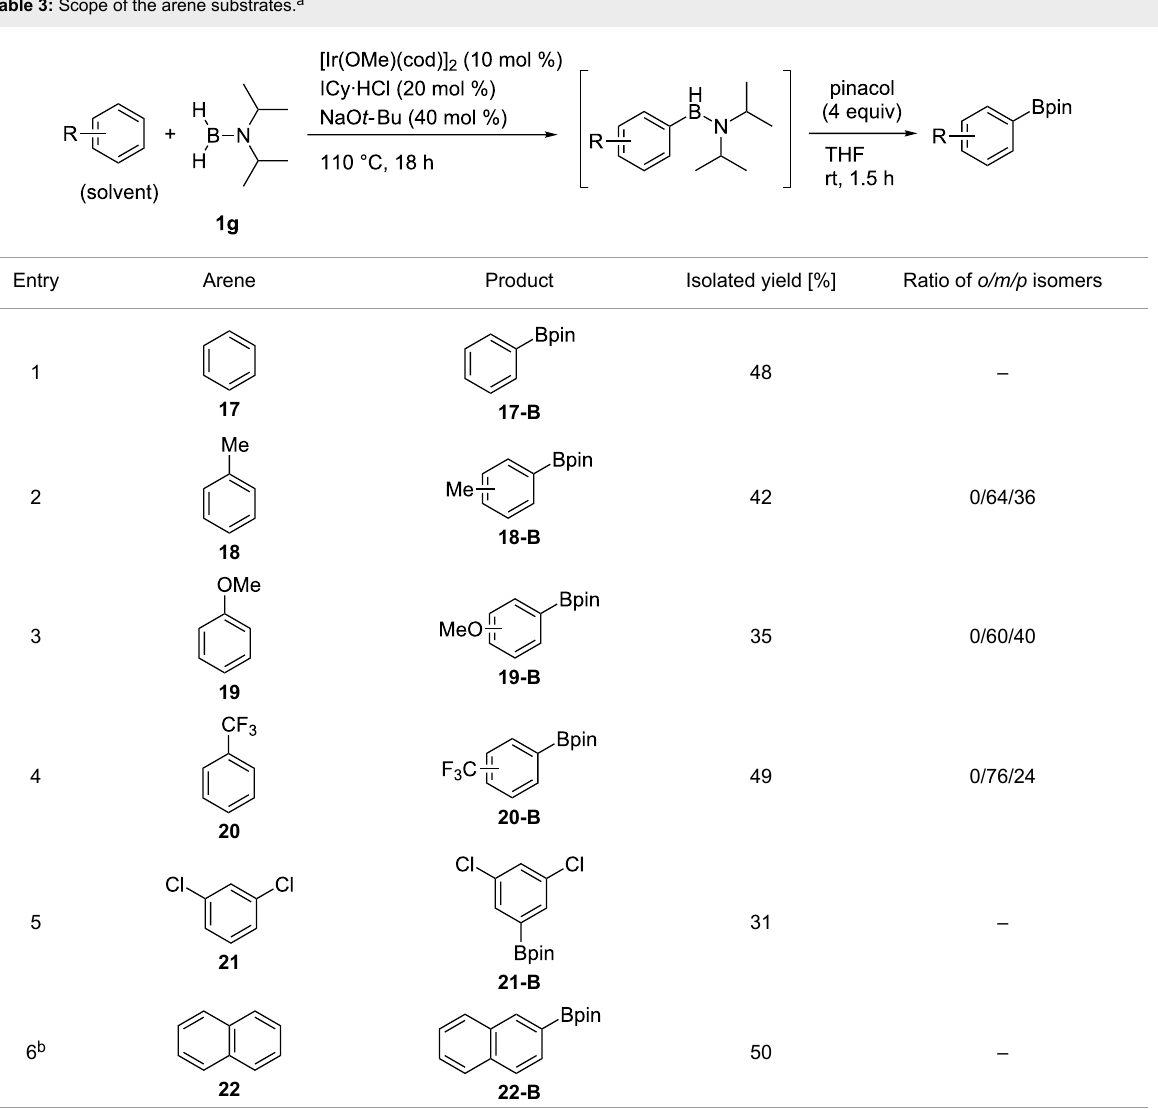
Table 3: Scope of the arene substrates.